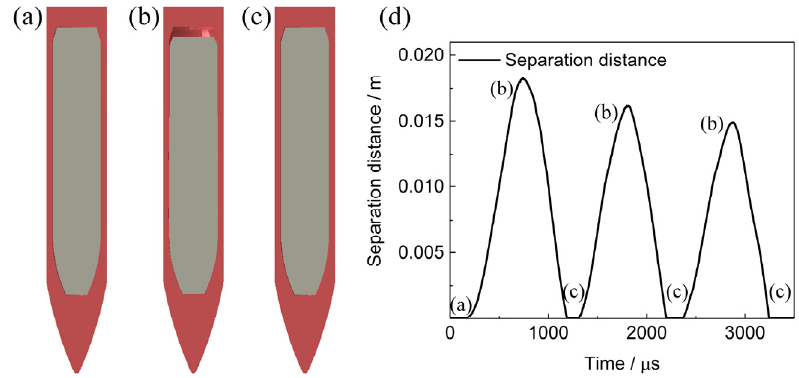
Figure 14. Deformation of the PBX1314 in the projectile. ( a ) The initial state. ( b ) Separation in the tail. ( c ) Impact in the tail part. ( d ) Separation distance of the tail surfaces of PBX1314 and the projectile.